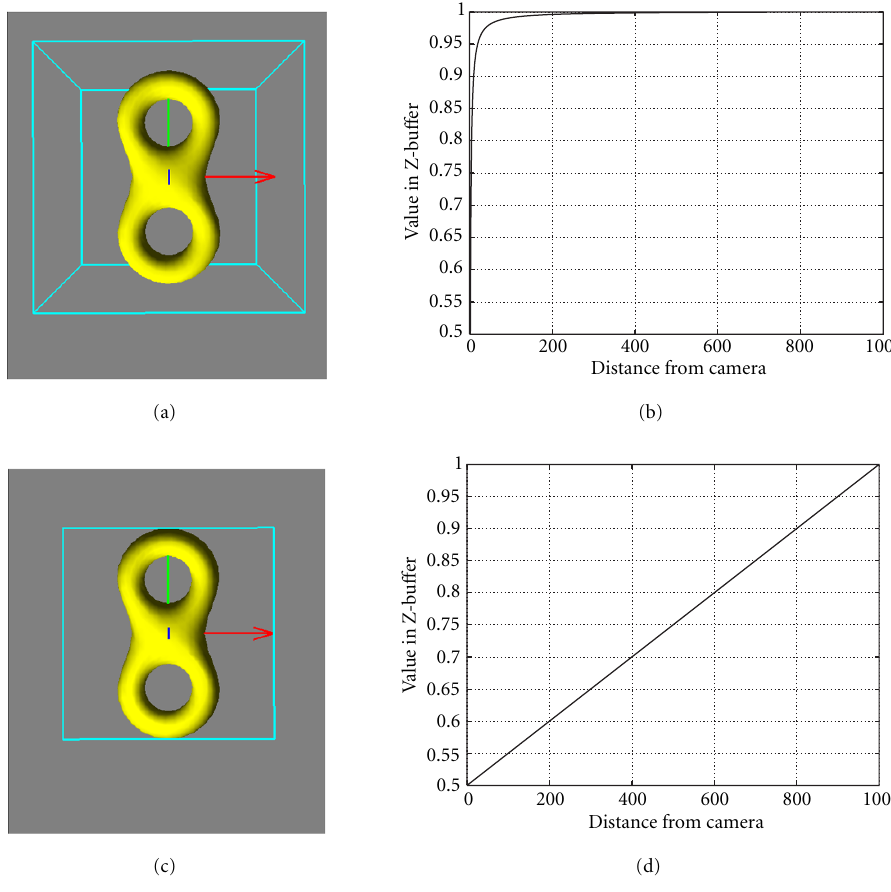
Figure 2: Camera models and their property of depth evaluation in OpenGL. (a) A perspective camera. (b) Depth change in a perspective camera. (c) An orthographic camera. (d) Depth change in an orthographic